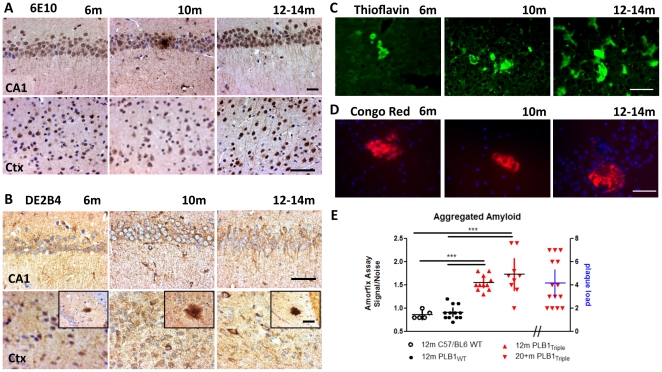
Amyloid histopathology in homozygous PLB1Triple mice.
A–D: Microphotographs from coronal sections of 6, 10, 12–14 months old animals; scalebars: 50 µm. A–B: Immunoreactivity towards APP/βA (6E10 and DE2B4 antibodies) was progressively seen in somata and processes of hippocampal pyramidal cells (CA1) and cortical neurones (Ctx). Occasional strong extracellular immunostaining demonstrates the formation of βA plaques, also visualised by Thioflavin-S and Congo Red fluorescence (C&D), confirming β-sheet protein folding and mature aggregation of extracellular deposits. Quantification of plaque load was conducted in 21 month old triples (E, 6E10 stain). The βA load was assessed based on the signal obtained in the Amorfix A4 assay for aggregated amyloid (see Methods and Text S1) and confirmed significantly enhanced levels in 12 and 20 months old PLB1Triple mice compared with wild-type C57/BL6 and PLB1WT lines (displayed as individual data points, mean and 95% CI, ***:P<0.001).